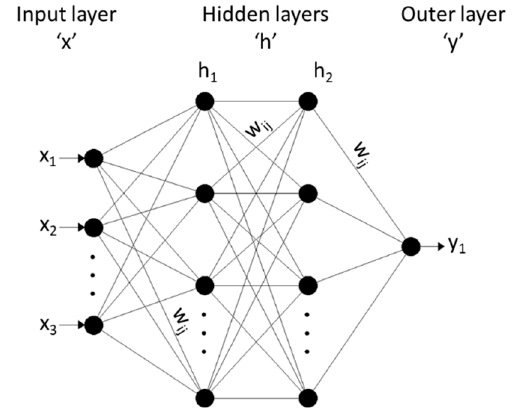
Figure 1. Feed-forward neural network Figure 1. Feed ‐ forward neural network architecture.